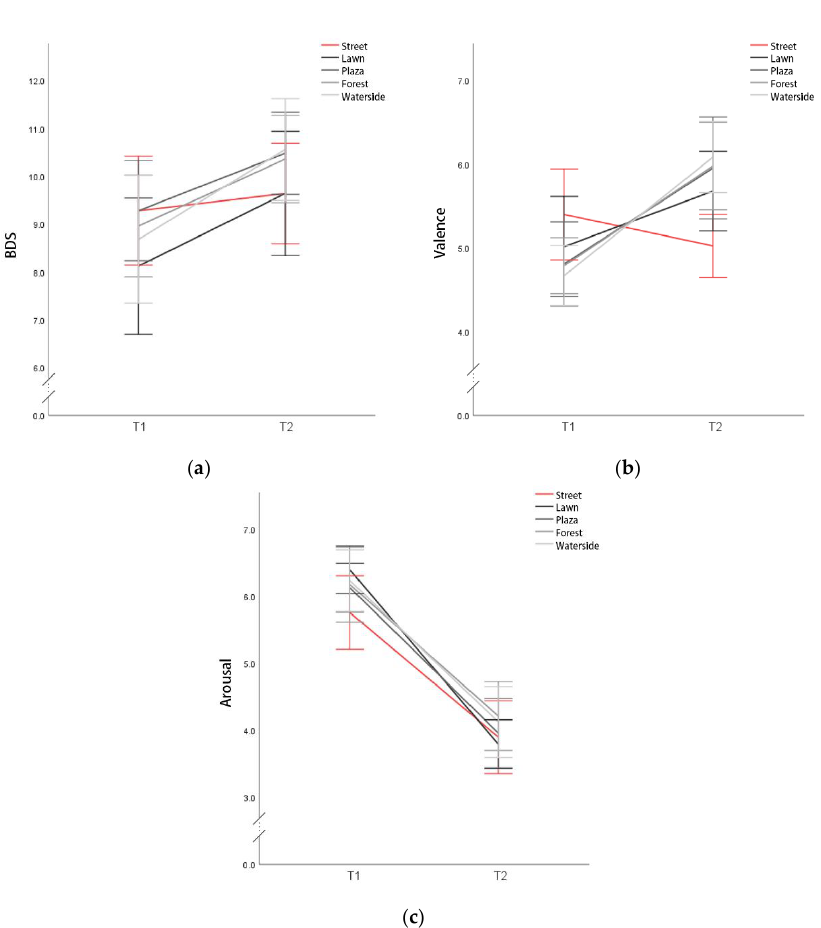
Figure 3. BDS ( a ), valence ( b ), and arousal ( c ) before and after viewing environment videos. The type of environment is represented by the five lines on two time-points. Note: T1 = pre-video, T2 = post-video.